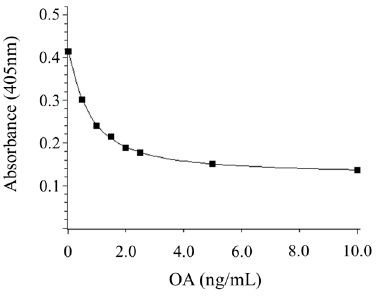
Figure 4. The calibration curve was obtained using the PP2A inhibition assay. The PP2A inhibition assay was conducted with OA standard solutions (0, 0.5, 1.0, 1.5, 2.0, 2.5, 5.0, and 10.0 ng/mL) prepared from OA CRM (CRM-OA-d). Each point represents the mean (n = 3) with an RSD of less than 2.5%. Table 2. Limits of detection (LOD) and quantitation (LOQ) for Mussel.